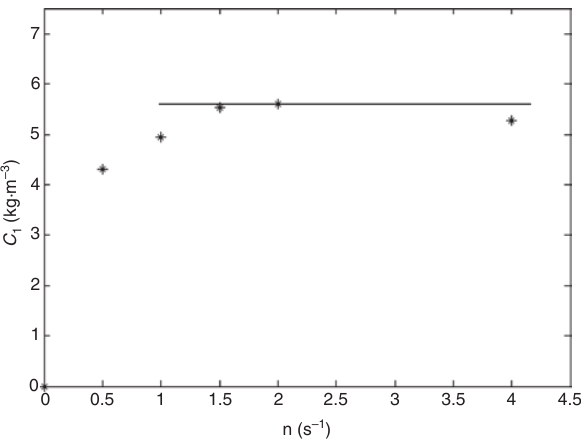
Figure 2: Dependence of Geranium sanguineum L. liquid phase concentration on the agitation rate at t = 20 ° C; ζ = 0.03 m 3 /kg and solvent water. Table 2: Values of the constants A , B , and H in Eq. (1). Plant raw material Working conditions